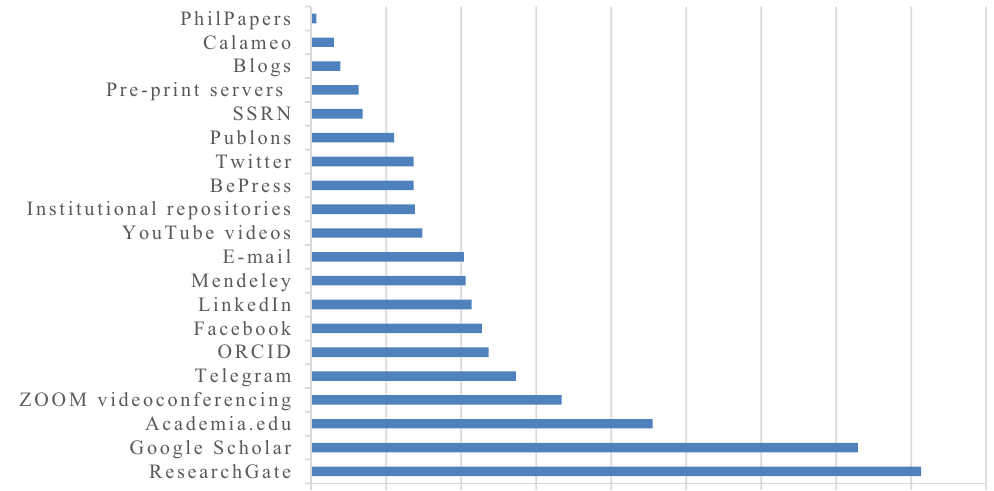
Figure 1. Percentage indicating the extent to which academic staff are utilizing specific digital tools for research